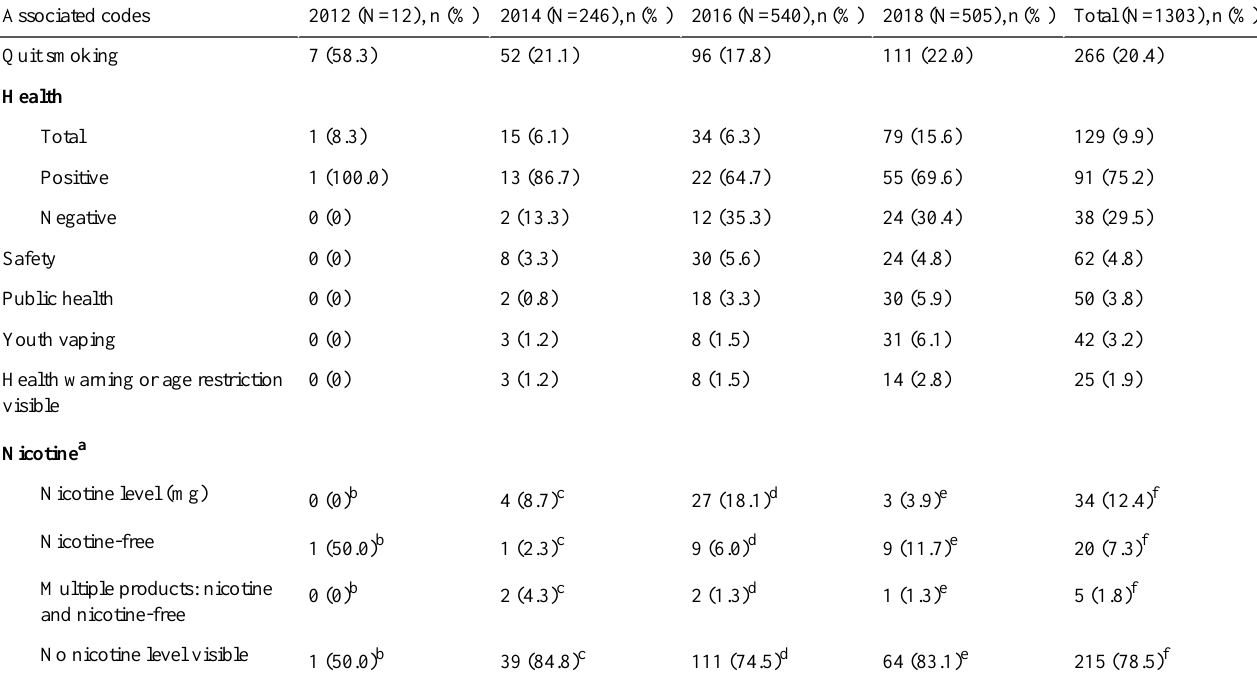
Table 5. Frequency statistics for each year corpus and the total sample within the “health, safety, and product claims”